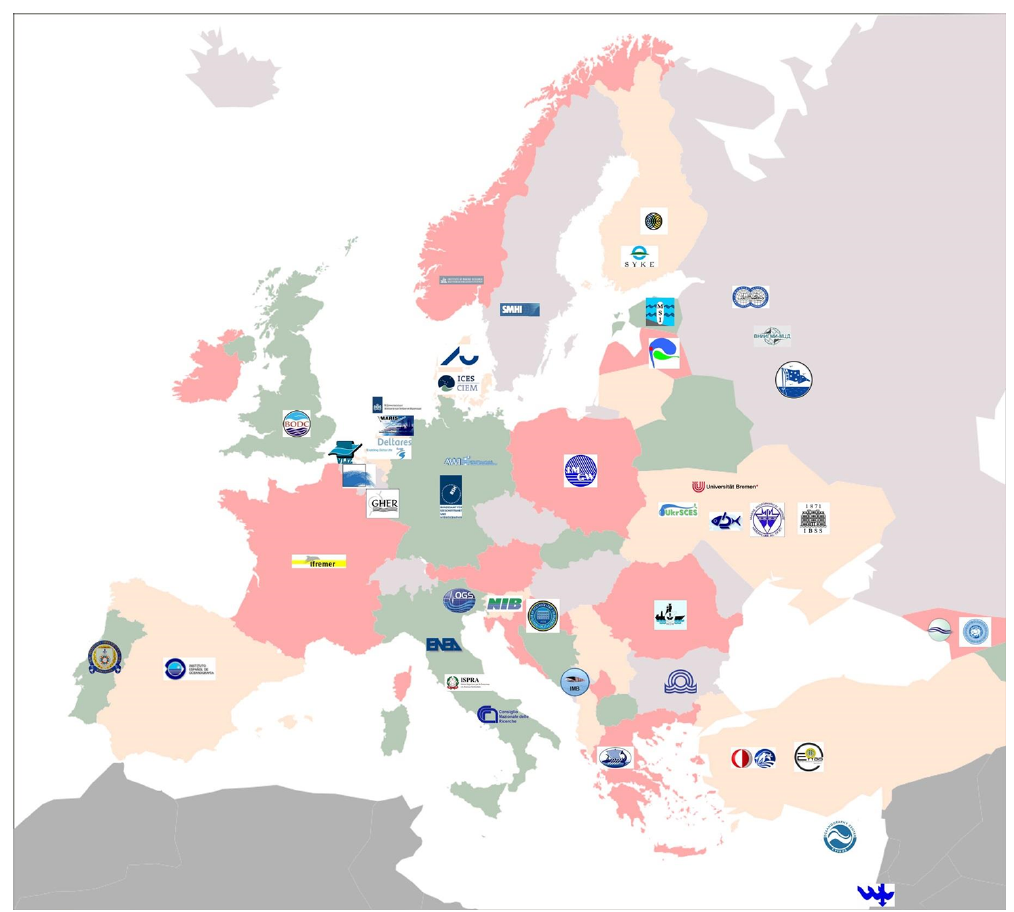
Figure 1. Geographic coverage of EMODnet Chemistry partnership. Logos indicate the nationality of the partner